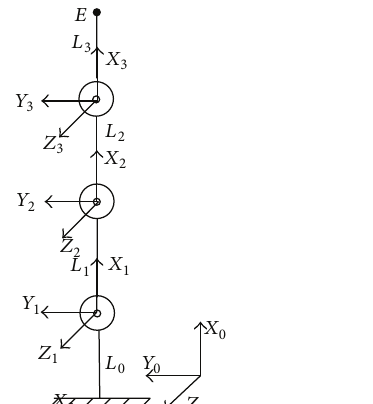
Figure 18: Omnidirectional Coefficient of plane.